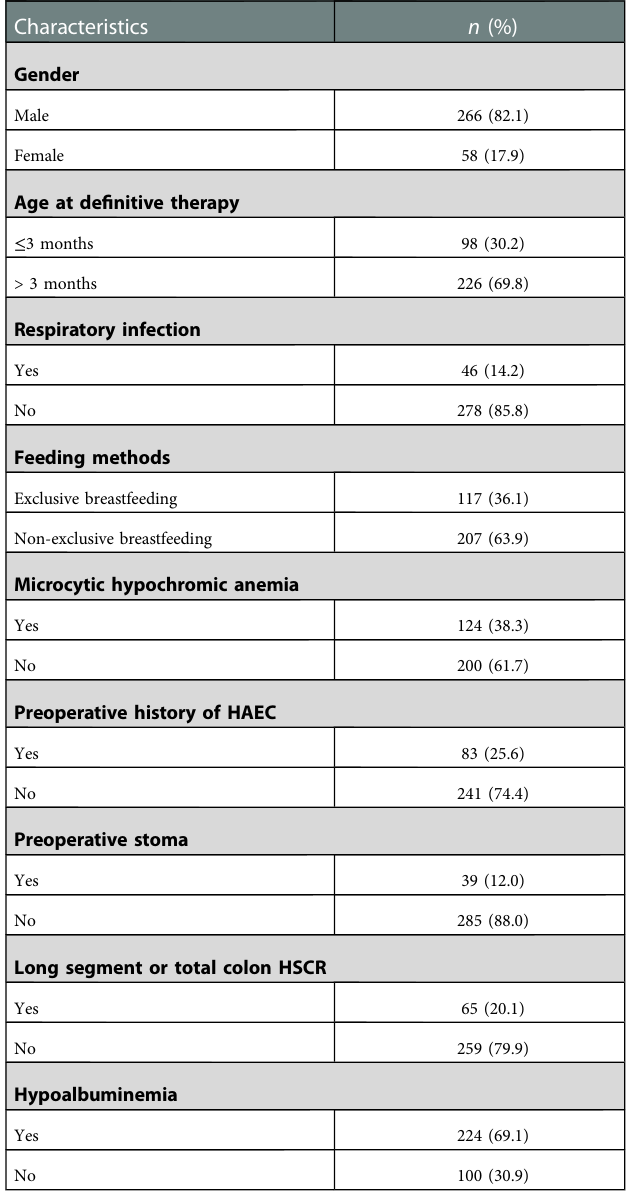
TABLE 2 Analysis of preoperative HAEC in children with HSCR. TABLE 1 Baseline characteristics of HAEC in children with